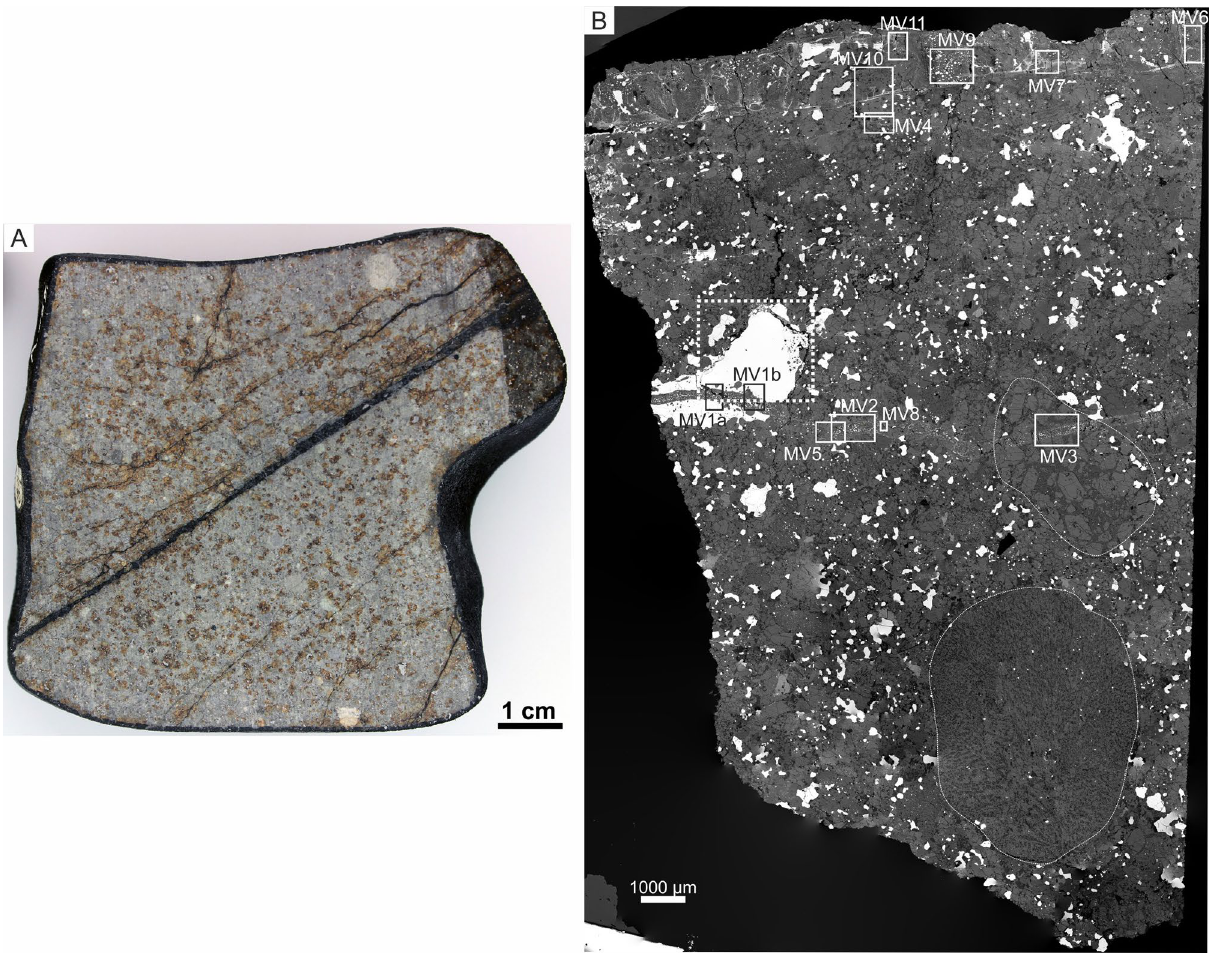
Figure 1. ( A ) Macrophotograph of Kakowa meteorite (NHMV-A557) with a straight melt vein cross-cutting the groundmass. ( B ) Back-scattered electron (BSE) image mosaic of Kakowa section (NHMV-N6231) showing the studied areas within the different melt veins (MVs). A dashed white rectangle shows the area that contains the pockets of exogenous material. Notable are the two large chondrules (delineated by fine white lines), one of them clearly cross-cut by